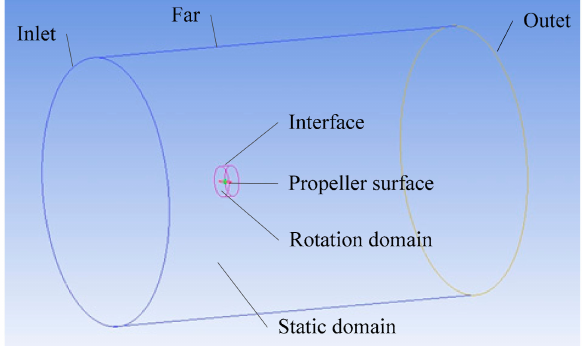
Figure 4. Domain and boundary of the propeller.